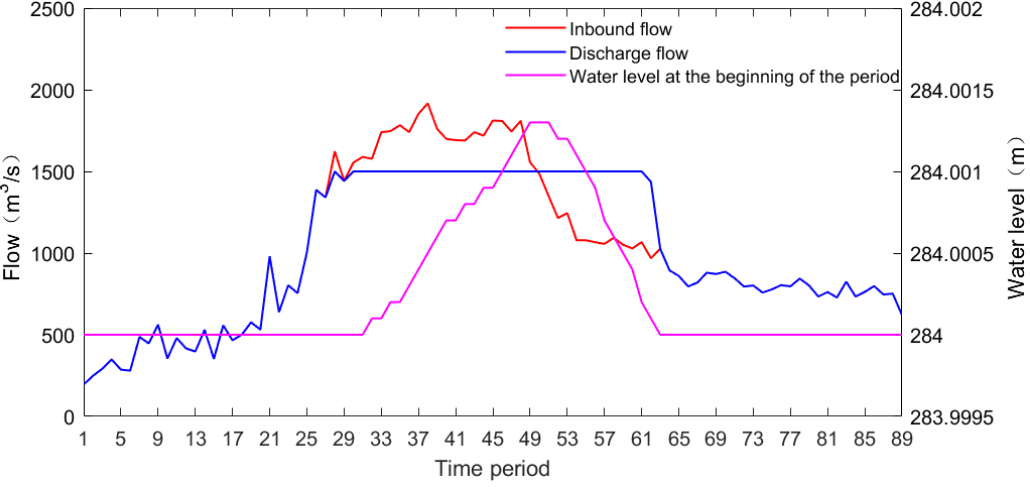
Figure 10. Conventional scheduling results of the second flood.